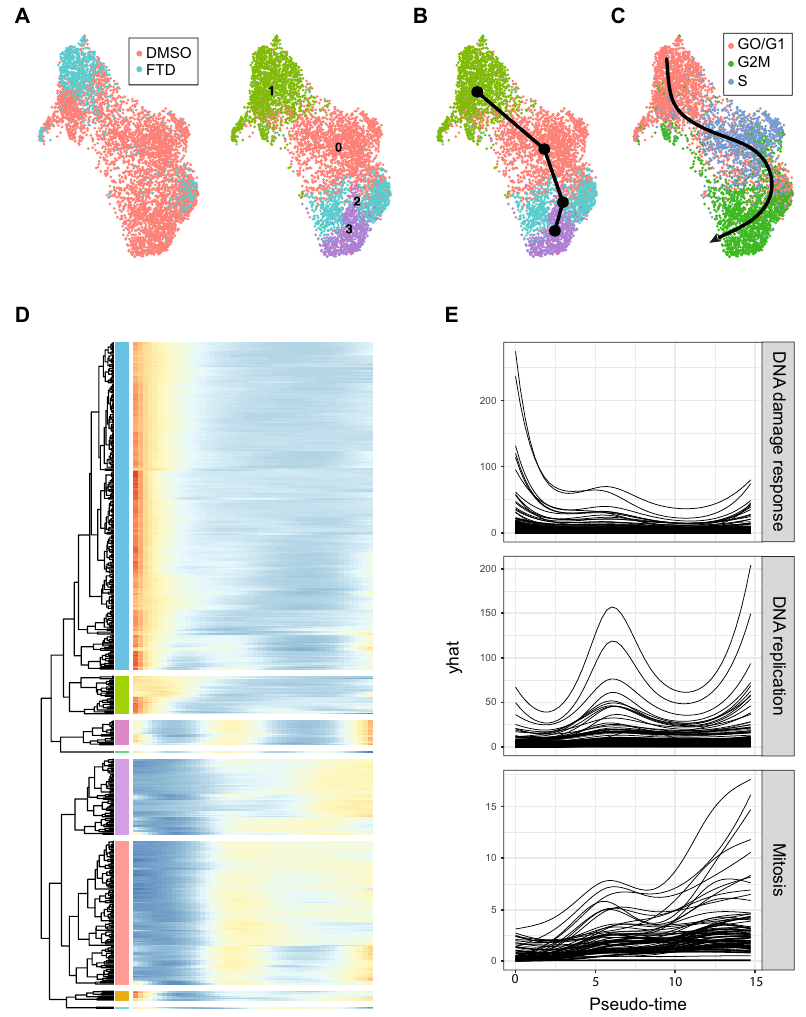
Figure 4. Trajectory analysis recapitulates p53-mediated cell cycle arrest. ( A ) UMAP projection of HCT116 cells at 72 h, colored by sample identity (left) and clustering (right), showing enrichment of treated cells in a subset of clusters. ( B ) Trajectory inference on this clustering identified a single lineage. ( C ) Trajectory curve overlayed on inferred cell cycle phase suggests an association between pseudo-time and cell cycle dependency. Direction of trajectory indicated by arrowhead. ( D ) Heatmap of pseudo-time vs gene expression for genes that discriminate between FTD and DMSO treated cells where the genes have been clustered. Each row corresponds to a gene and each column to a pseudo-time point with the starting point at the left. ( E ) Fitted pseudo-time— gene expression curves for the three largest